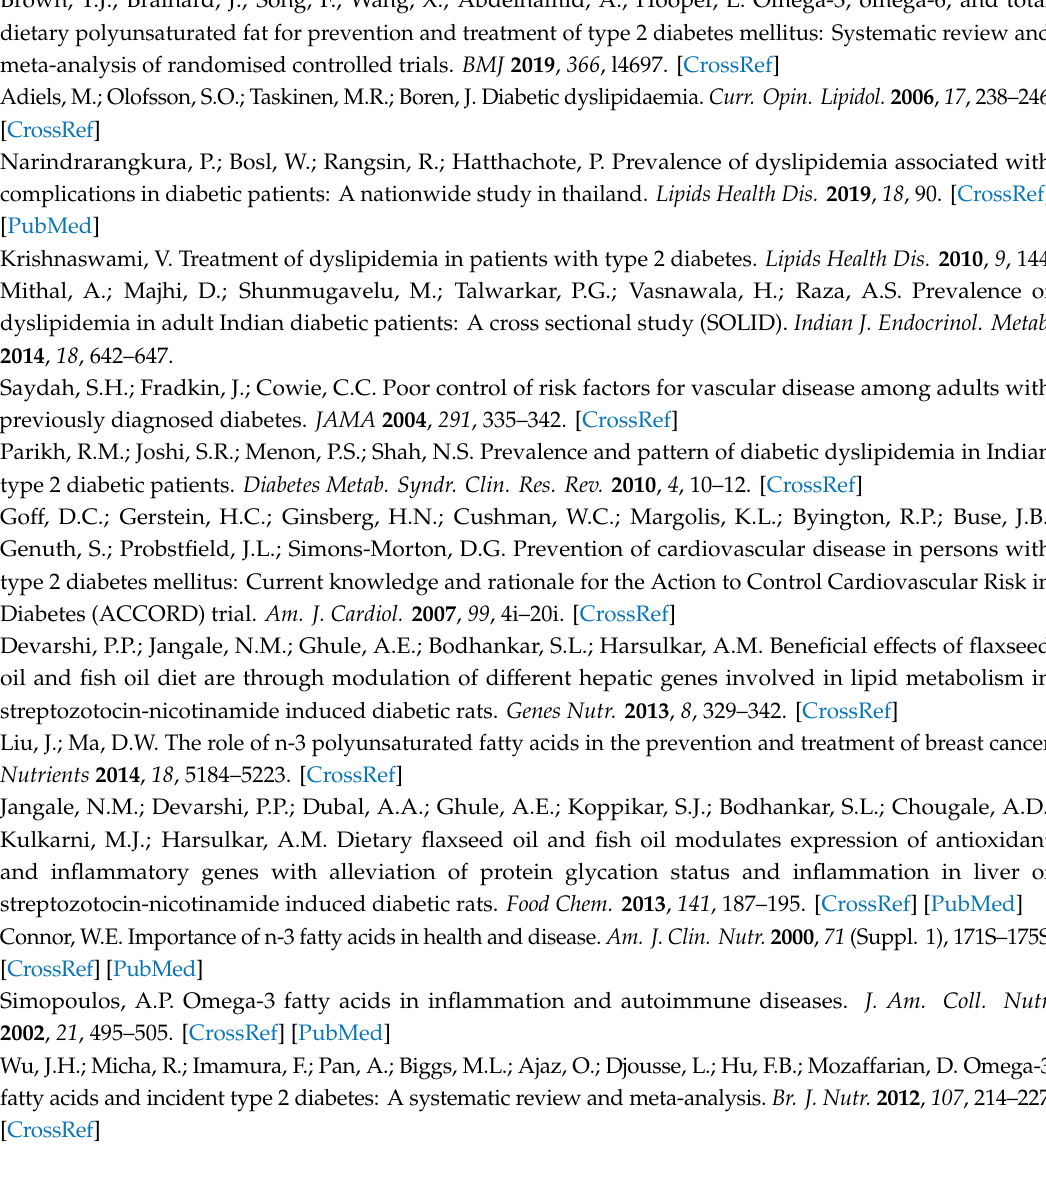
Figure S1: Assessment of glucose and lipid profile before diabetes development, Figure S2: LFT and KFT before diabetes